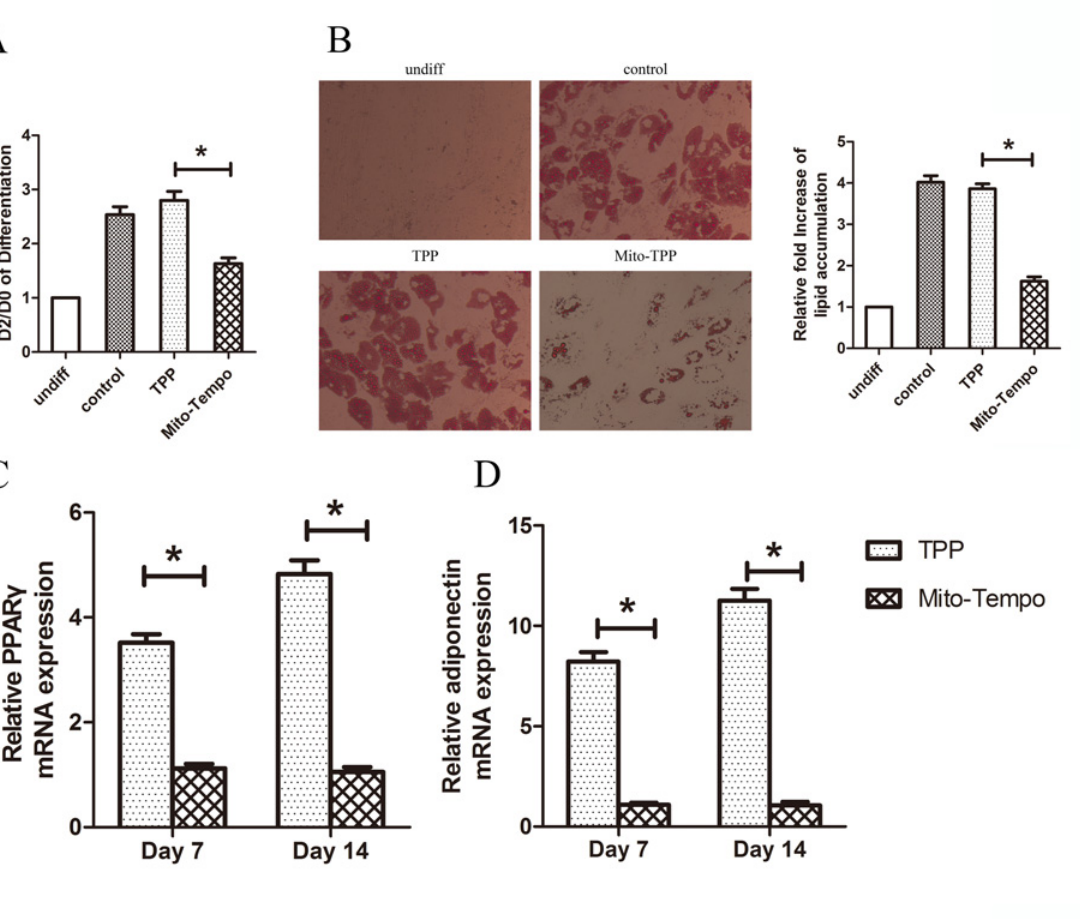
Fig 4. Mito-Tempo diminished adipocyte differentiation. (A) ROS levels in human MSCs on Day 0 and Day 2 of differentiation. Cells were treated with 500 nM of TPP or Mito-Tempo for 4 h prior to measurement on Day 2. (B) Mito-Tempo diminished lipid accumulation. Human MSCs were treated with 500 nM of Mito-Tempo starting on Day 2 of differentiation. Cells were fixed and stained with oil red O on Day 14. The oil red-O was extracted with isopropanol and absorbance was measured at 518 nm. (C, D) Gene expression of PPAR γ and adiponectin was decreased in the presence of Mito-Tempo on Day 7 and Day 14 of differentiation. * P <